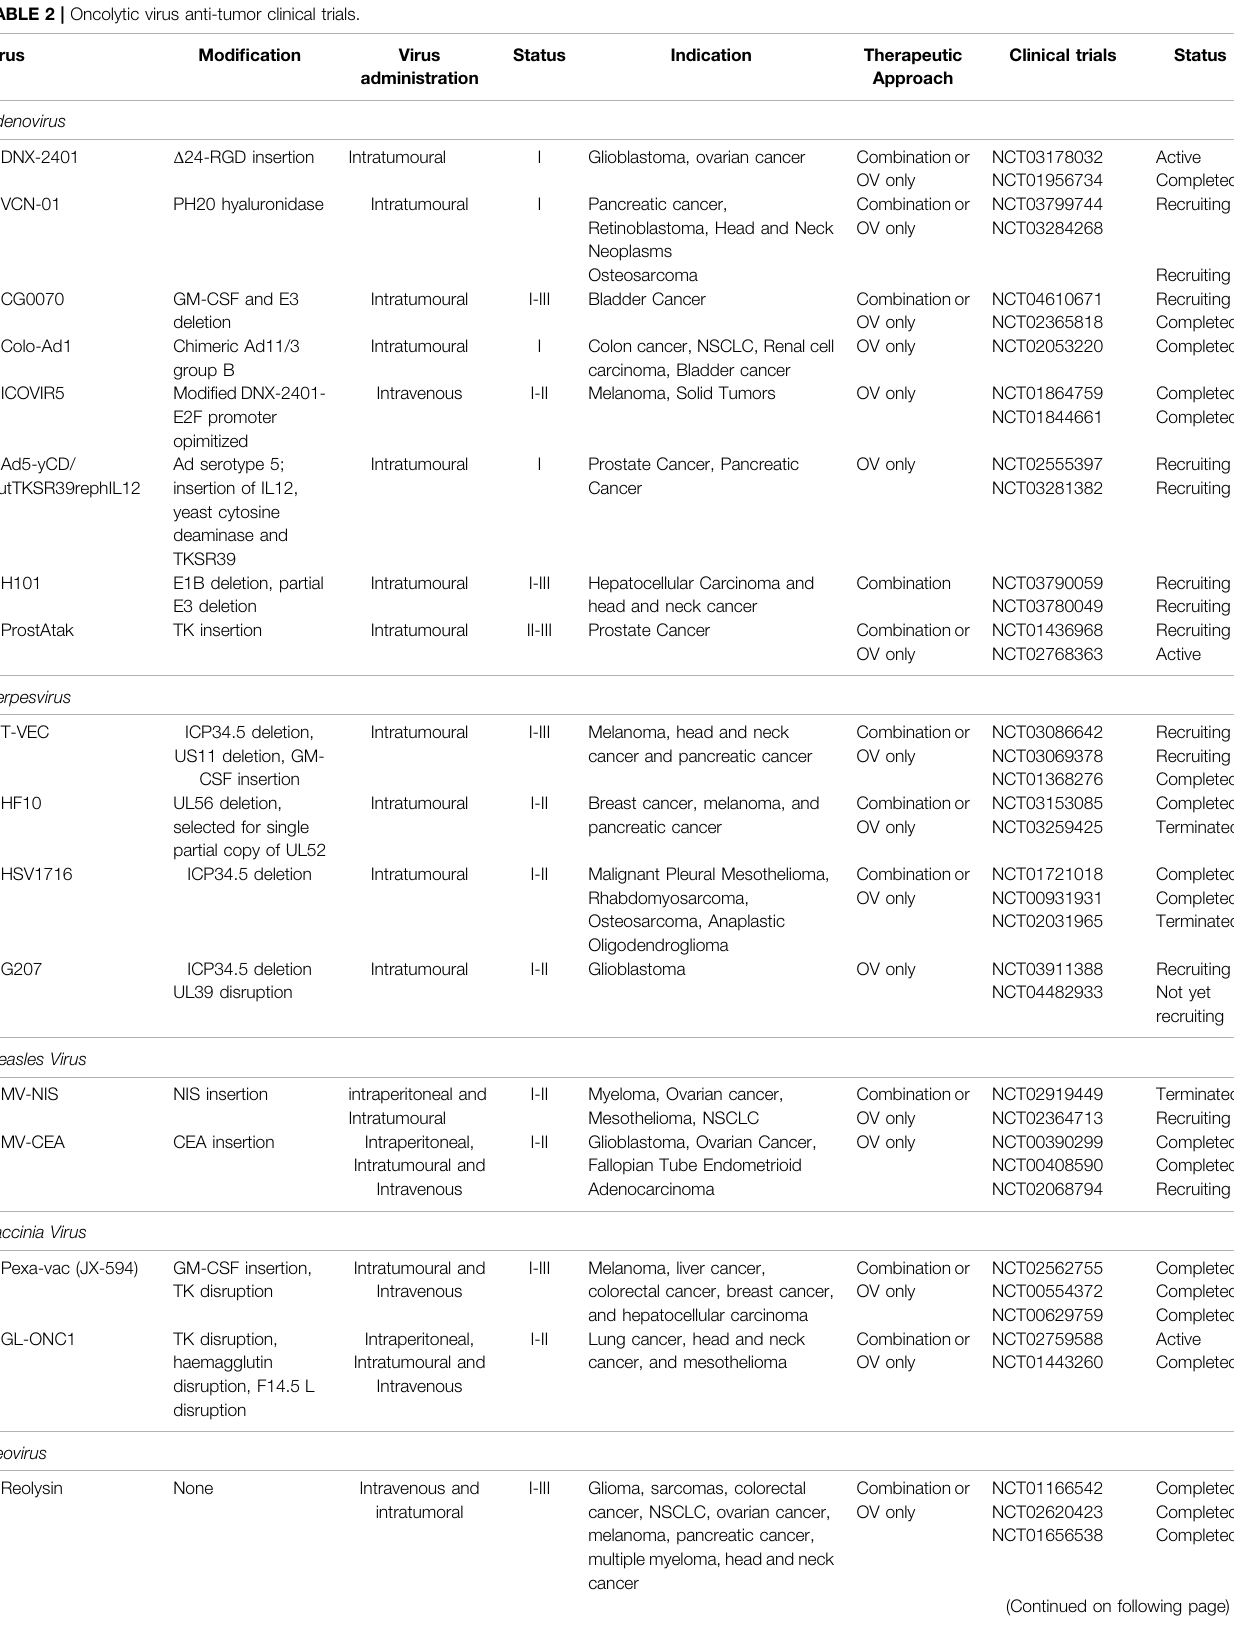
TABLE 2 | Oncolytic virus anti-tumor clinical